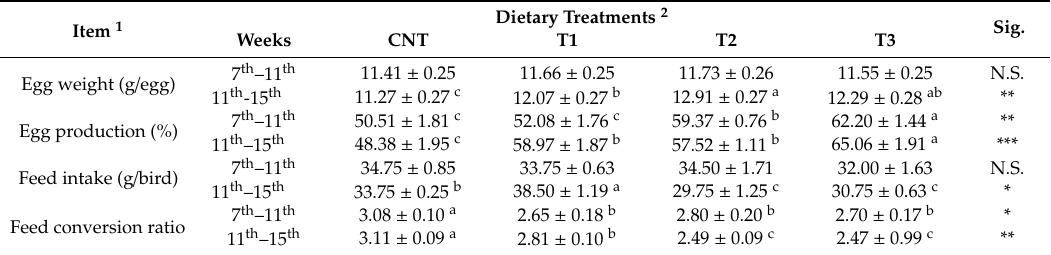
Table 4. E ff ect of the Moringa oleifera supplementation on the laying performance of Japanese quail, during the experimental period.